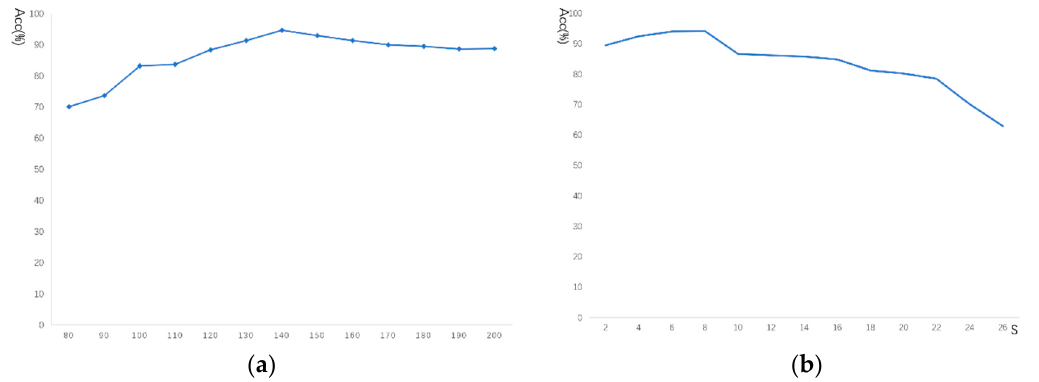
Figure 13. ( a ) The values of Acc corresponding to the values of different parameter C. ( b ) The values of Acc corresponding to the values of different parameter S.